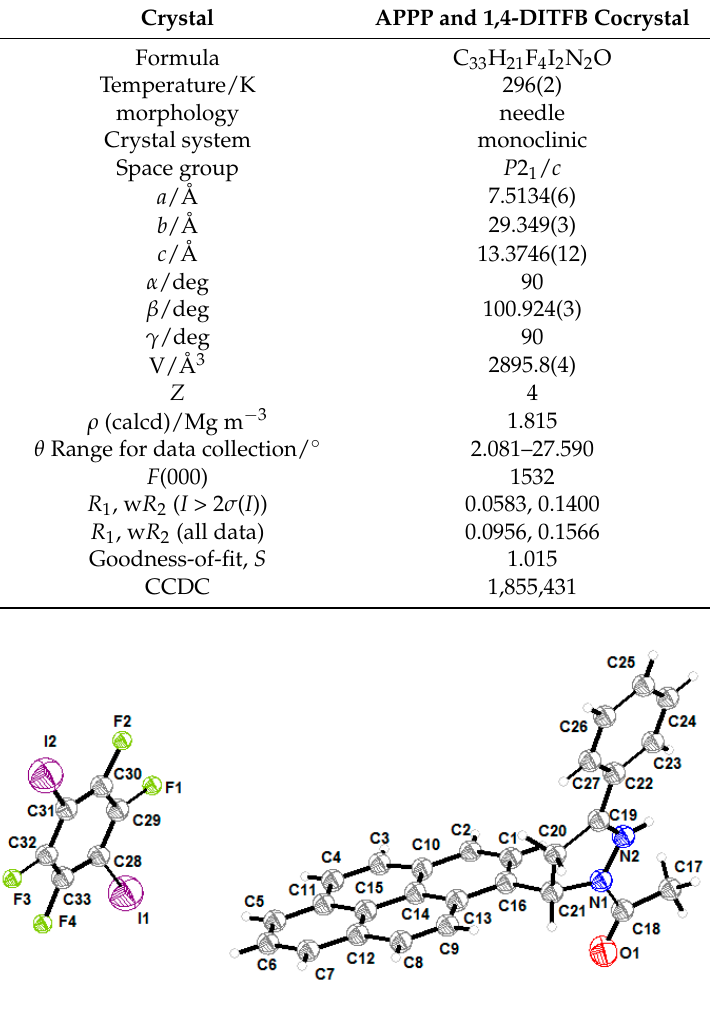
Figure 1. The ORTEP plot of the cocrystal.